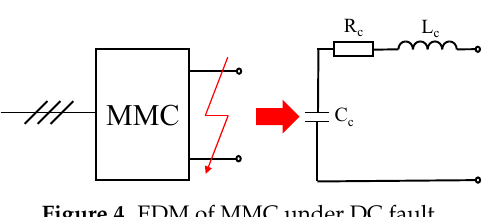
Figure 4. EDM of MMC under DC fault. Table 3. Comparison of different MMC model.